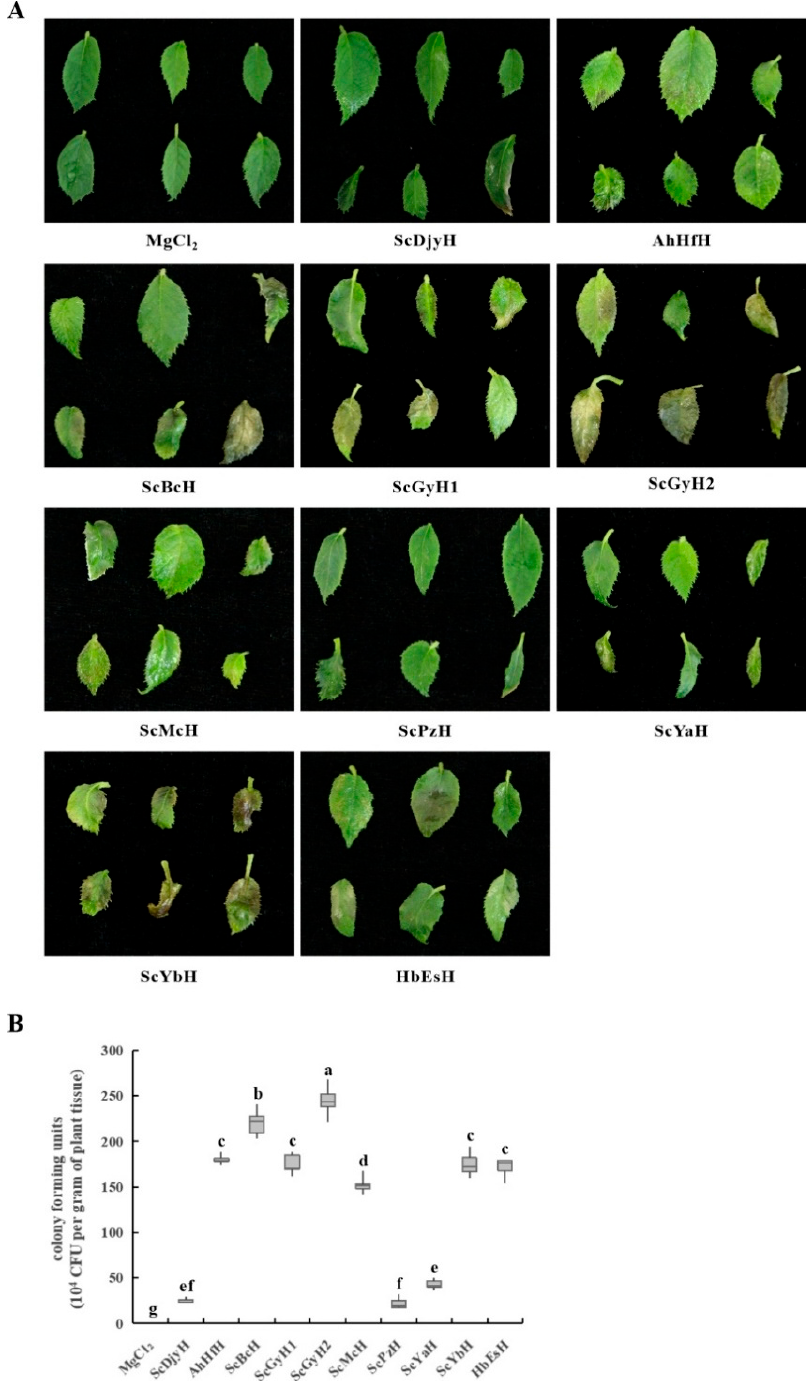
Figure 1. Disease symptoms and bacterial populations in ‘Hongyang’ infected by Psa strains. The tissue-cultured ‘Hongyang’ explants were flood inoculated with Psa bacterial suspension (5 × 10 8 CFU), and 10 mM MgCl 2 was used as a control. Disease symptoms ( A ) and Psa populations ( B ) of explant leaves were scored at 12 dpi. Different letters on the boxes indicate statistical differences at p < 0.05.